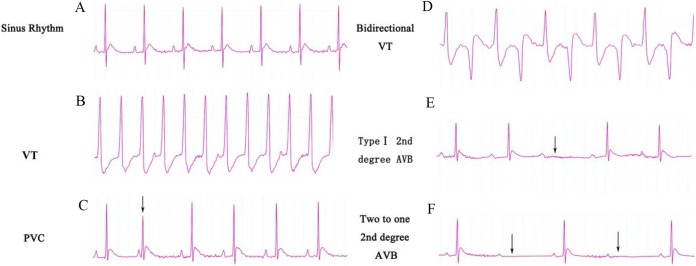
ECG categories that appeared in this experiment.(A) Sinus rhythm; (B) VT, ventricular tachycardia; (C) PVC, premature ventricular contraction; (D) Bidirectional VT; (E) Type I second degree AVB; (F) two to one second degree AVB. AVB, atrioventricular block.